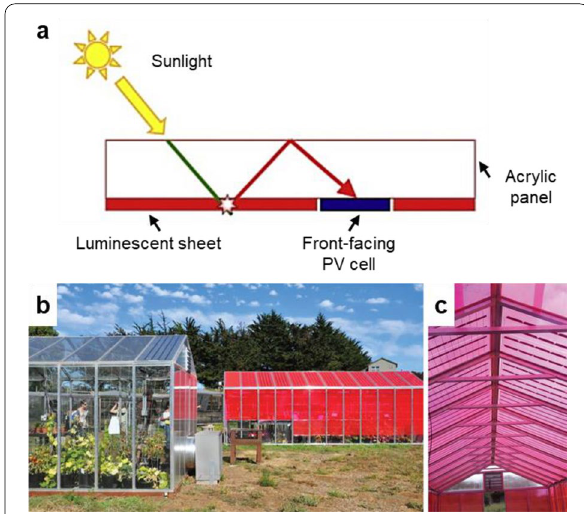
Fig. 7 a Schematic illustration of a wavelength selective photovoltaic panel with bottom-mounted solar cells. b Greenhouse constructed with wavelength selective photovoltaic panels (red colors) at the University of California Santa Cruz Arboretum. c Photograph of the greenhouse roof with narrow photovoltaic strips (black lines in red panels) for electricity generation. Reproduced with permission